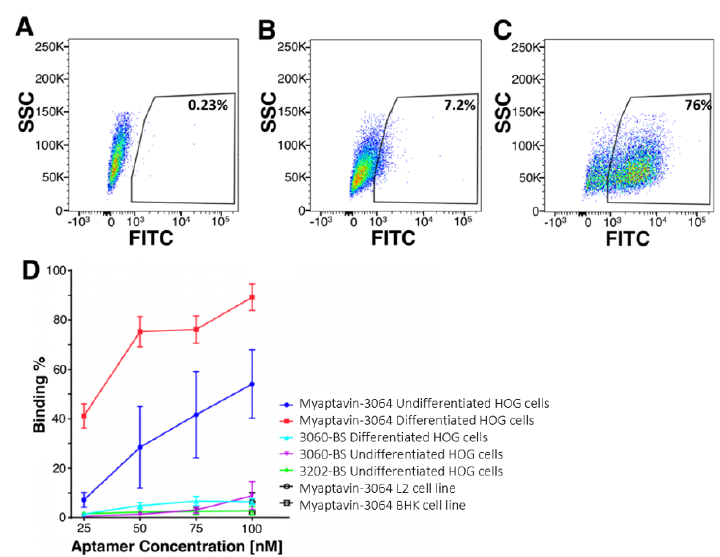
Figure 2. Adherence of Myaptavin-3064 to HOG cells measured by flow cytometry. Shown are flow cytometric signals from HOG cells incubated with no aptamer ( A ), 50 nM 3060-BS negative control aptamer conjugate ( B ), or 50 nM Myaptavin-3064 conjugate ( C ). Gating was set with reference to staining with negative control 3060 BS 50 nM aptamer conjugate. Concentration-dependent binding studies ( D ) show binding of Myaptavin-3064 to undi ff erentiated HOG cells (blue line with filled circles), di ff erentiated HOG cells (red line, filled squares) compared to 3060-BS binding to either di ff erentiated (cyan line, filled triangle) HOG cells or undi ff erentiated HOG (magenta closed triangle). Myaptavin-3064 binding to L2 cells (black line open circle) and to BHK cells (black line open squares) are also shown. SCC: side scatter channel; FITC: fluorescein-5-isothiocyanate.